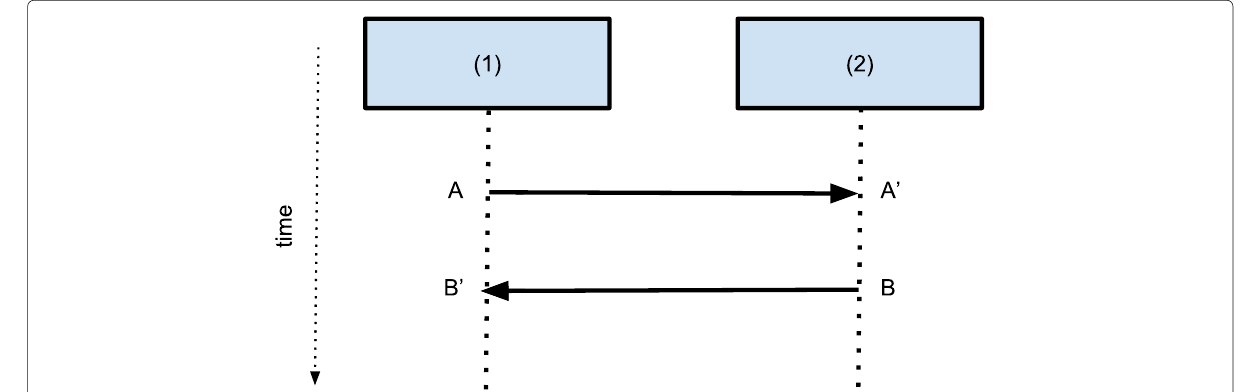
Fig. 2 Message exchange between different software modules and circular